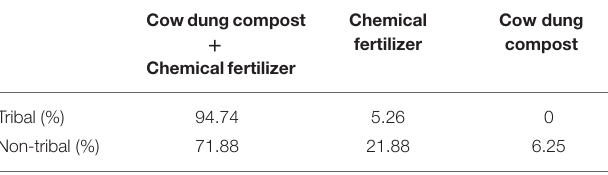
TABLE 7 | Techniques to improve soil fertility currently implemented by the participants on their farms.